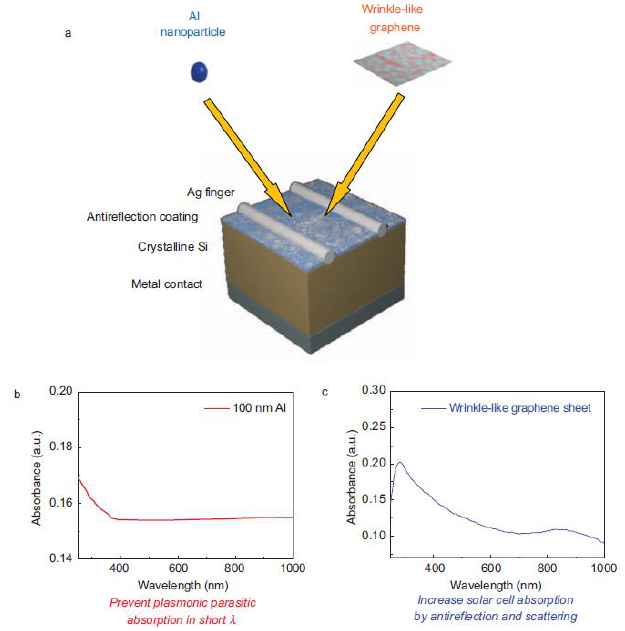
Figure 8. Illustration of proposed textured Al nanoparticle/graphene-enhanced screen-printed solar cell [68]. Appl. Sci. 2020 , 10 , x FOR PEER REVIEW